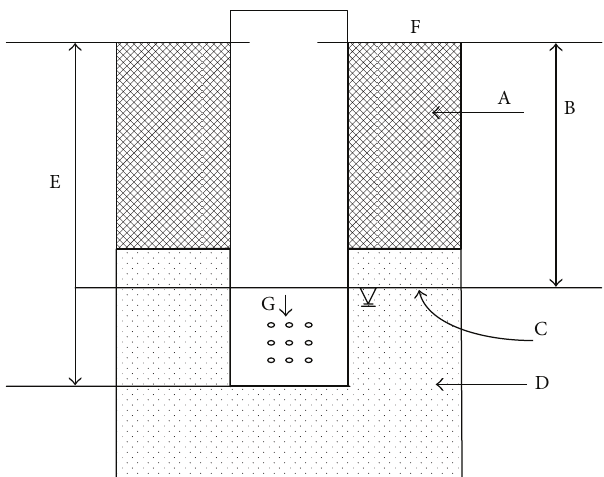
Figure 2: Schematic diagram of groundwater monitoring well (A: soil layer; B: depth of groundwater; C: groundwater level; D: sand layer; E: depth of groundwater monitoring well; F: soil surface; G: